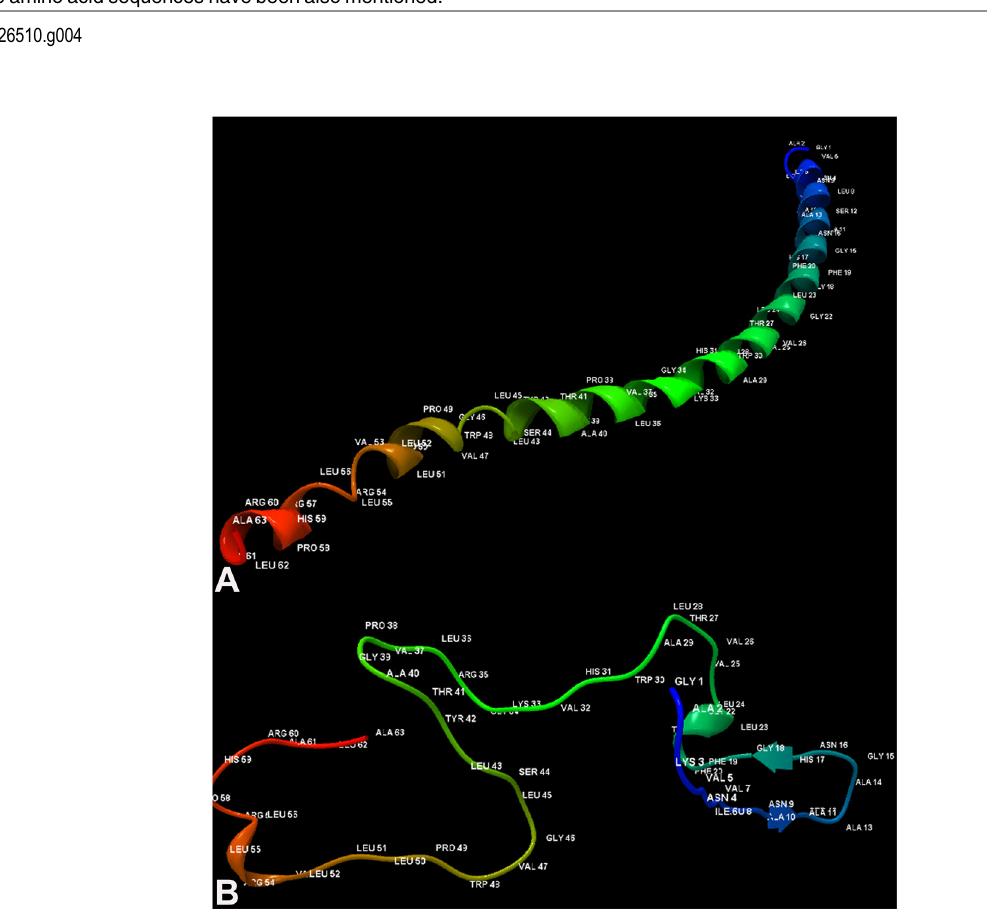
Fig 4. Modeled p7 alignment between GT3 and GT4 amino acid sequence and their conserved regions. The degrees of conservation as well as the consensus between the amino acid sequences have been also